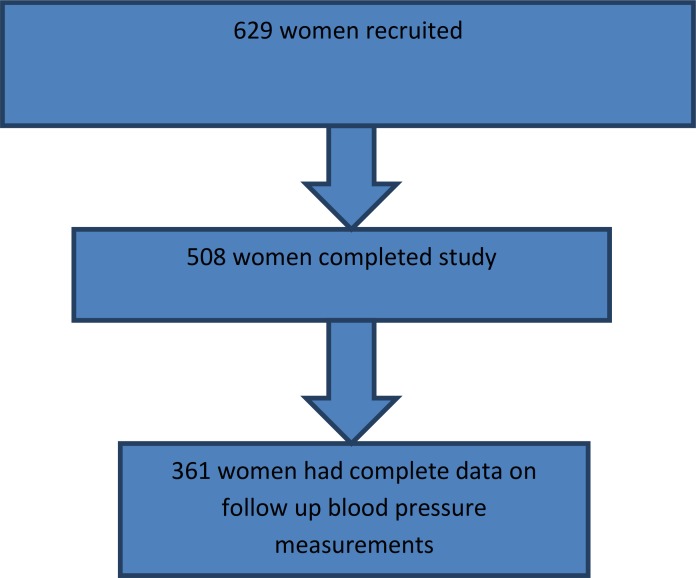
Flow chart of participants in the study.